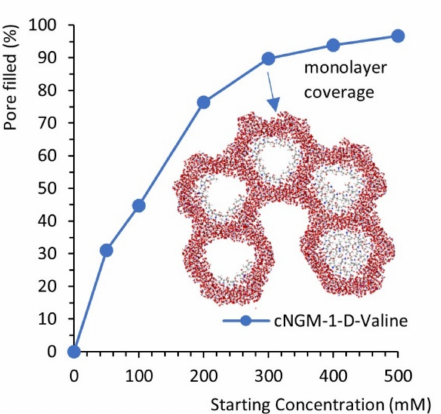
Figure 6. X-ray diffractograms showing the evolution of diffraction peaks associated with crystalline valine (asterisks) and a single broad peak at 18.3 ◦ (arrow) observed at lower adsorption levels of the preferred valine enantiomer only. For clarity, the diffractogram for the sample at 500 mM is not